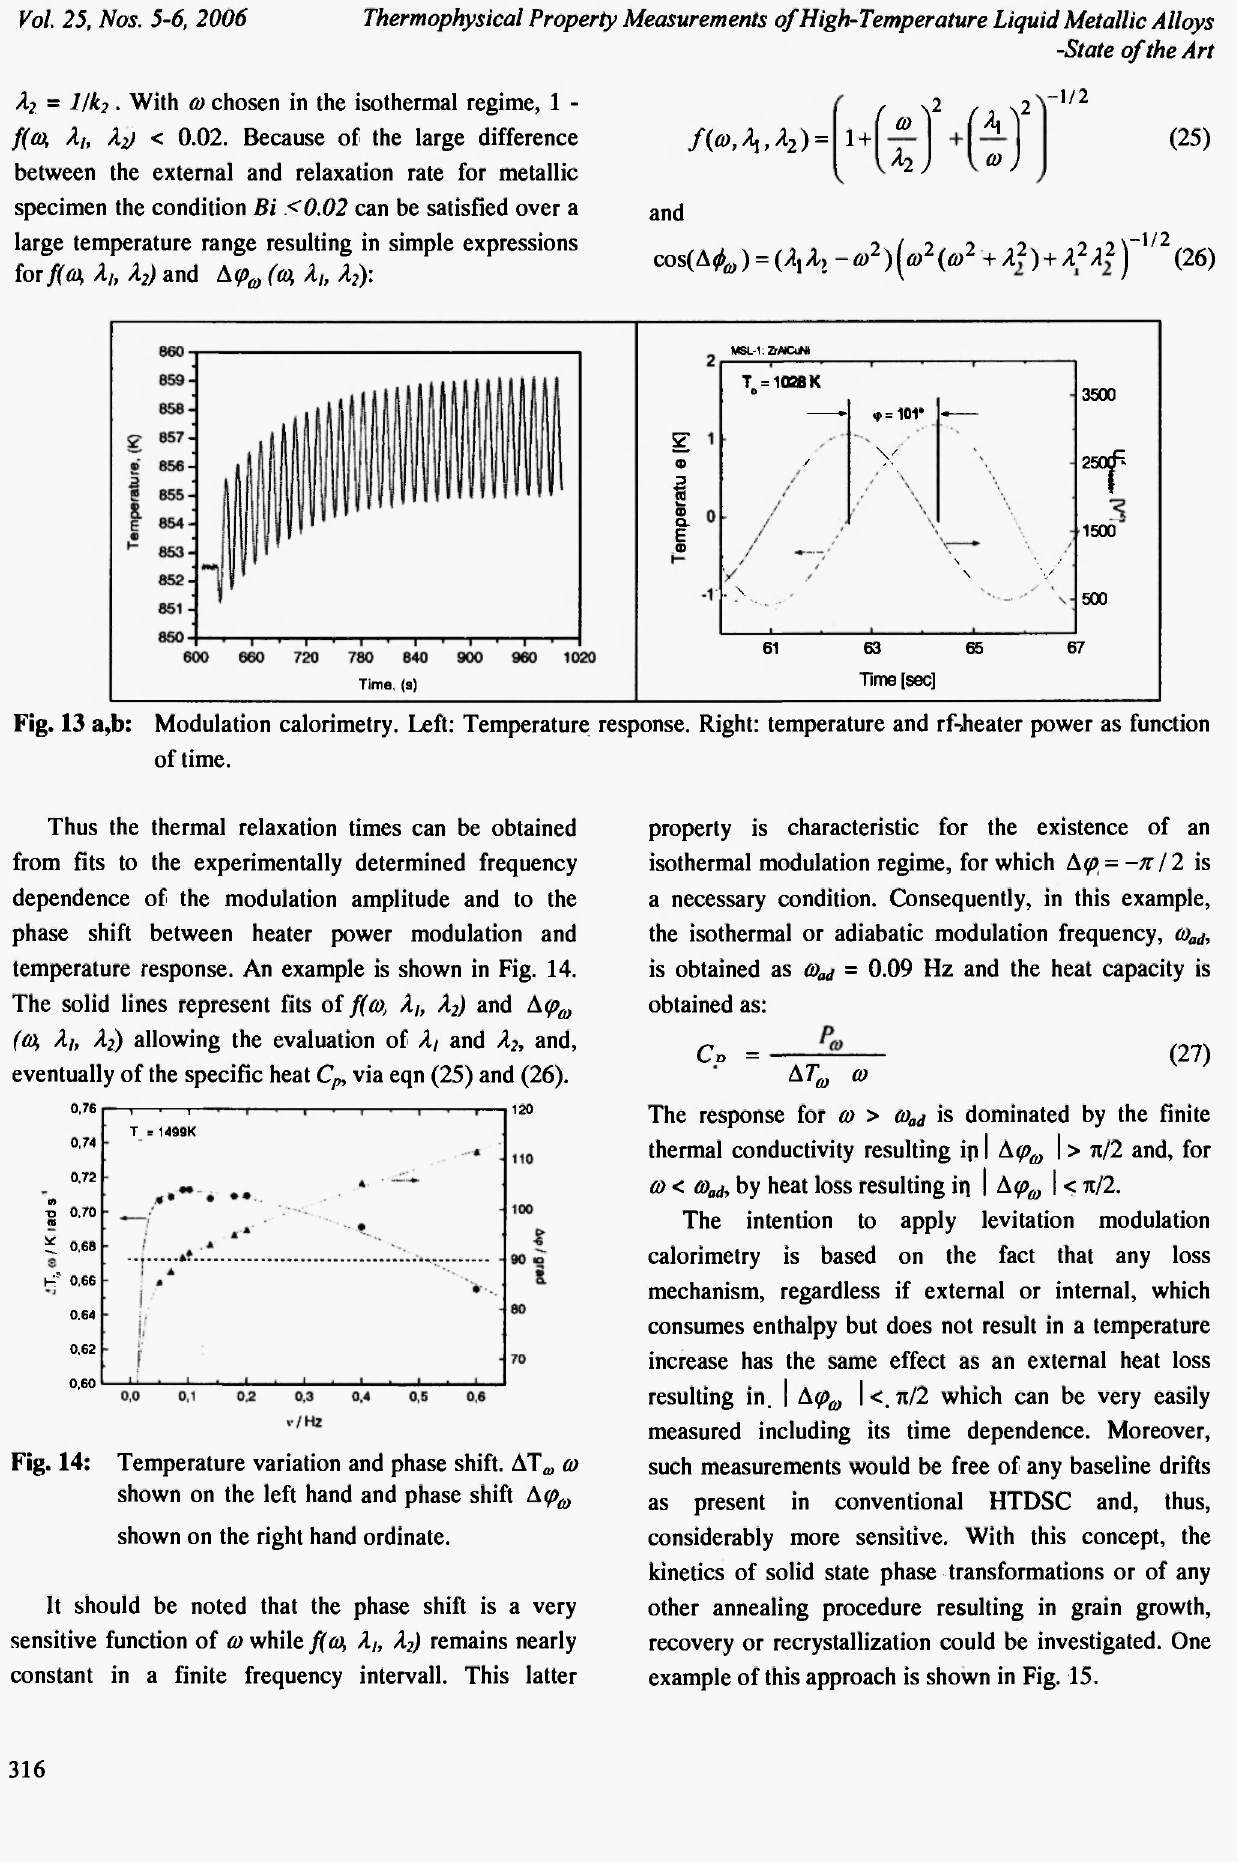
Fig. 14: Temperature variation and phase shift. ΔΤ ω ω shown on the left hand and phase shift Δφ ω shown on the right hand